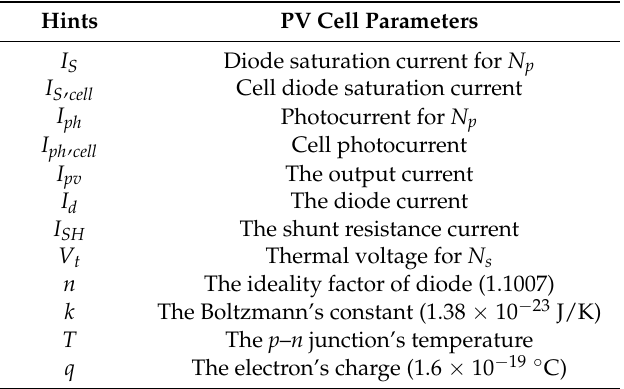
Table 1. PV Cell Parameters.